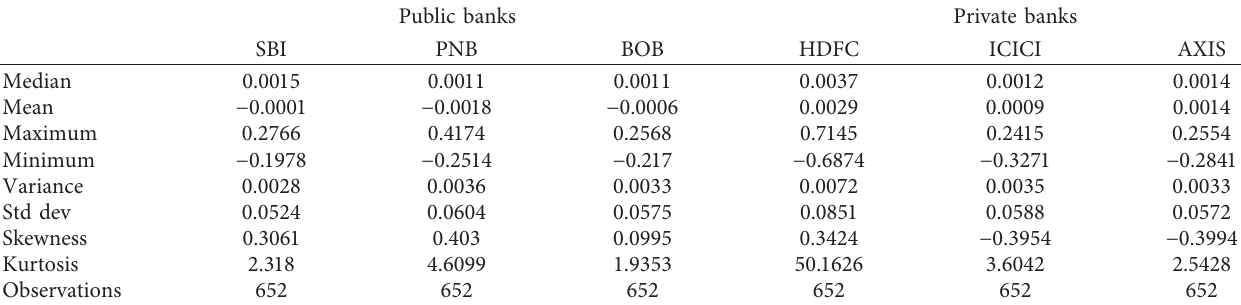
Table 2: Descriptive